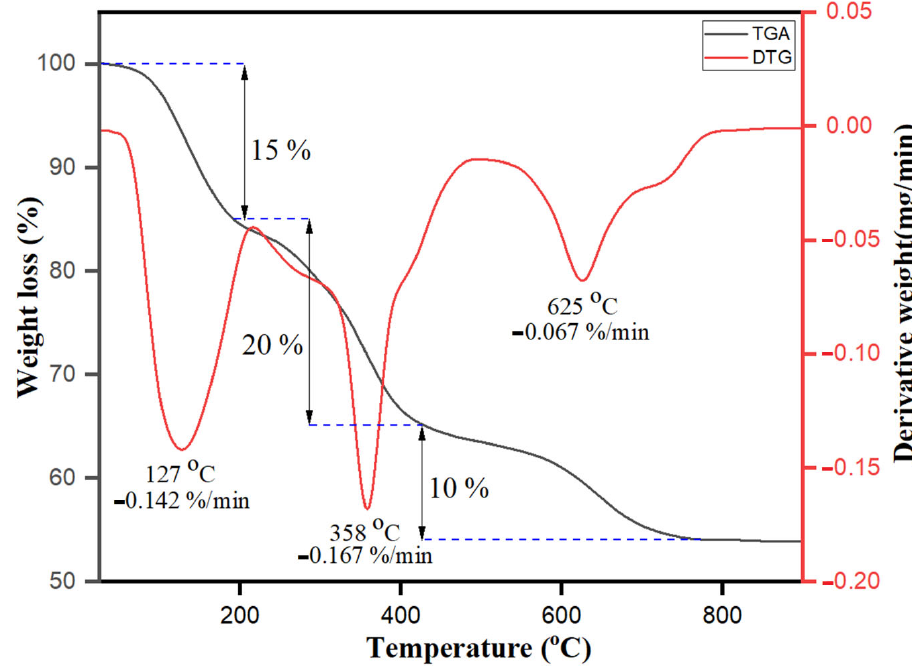
Figure 6. TGA − DTG analysis of bio ‐ fabricated ZnONPs.